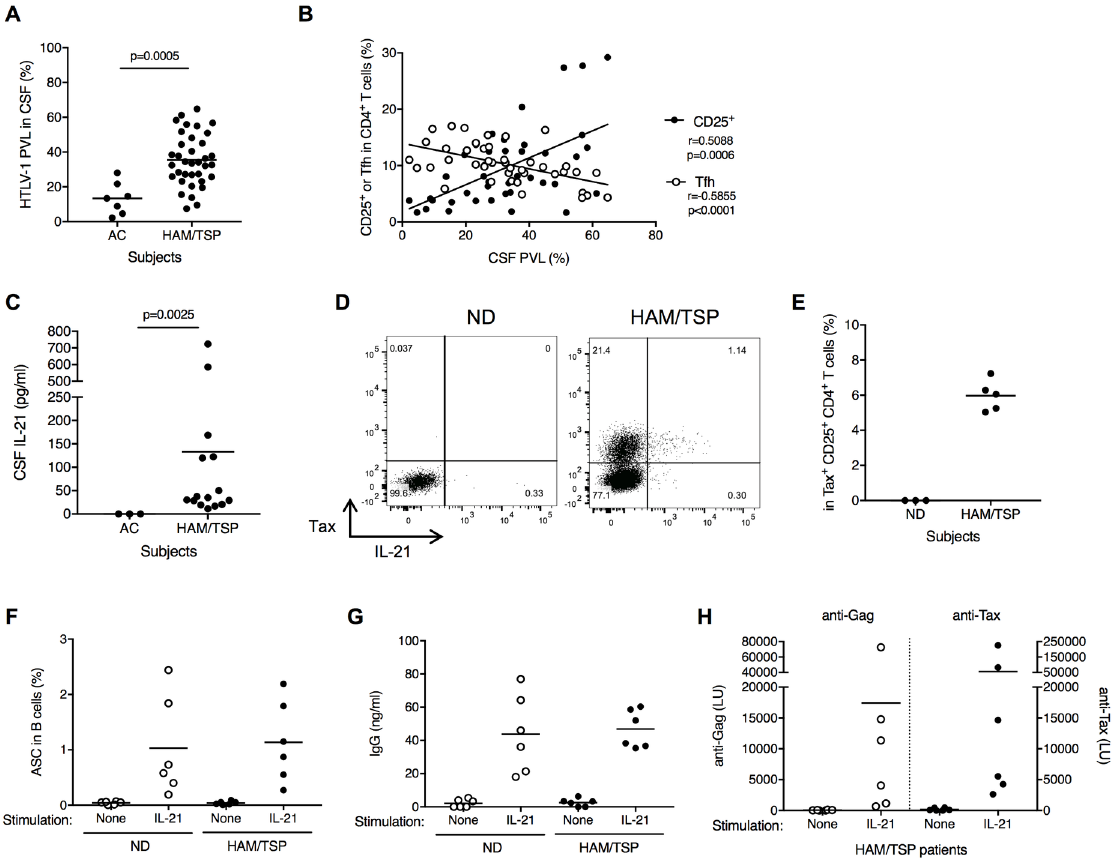
Fig 6. Involvement of CD4 + CD25 + T cells with B cell help in CSF of HAM/TSP patients. (A) Comparison of HTLV-1 PVL in CSF of ACs (n = 7) and HAM/TSP patients (n = 36) using Mann-Whitney Test. (B) Correlation of HTLV-1 PVL with CD4 + CD25 + T cells and memory Tfh cells in HTLV-1-infected subjects using Spearman’s rank correlation test. (C) Comparison of IL-21 in CSF of HAM/TSP patients and ACs using unpaired t test. (D) Representative dot plots of IL-21 and Tax staining in CD4 + CD25 + T cells of a ND and a HAM/TSP patient after culture for 24 hours without any exogenous stimulation. (E) Detection of IL-21 in Tax-expressing CD4 + CD25 + T cells of HAM/TSP patients after culture for 24 hours without any exogenous stimulation. (F) Generation of ASCs subsets in B cells cultured with and without rhIL-21. The data were obtained from cultured B cells of NDs and HAM/TSP patients (n = 6). The horizontal line represents the mean. (G) Detection of human IgG in the B cell culture supernatants of NDs and HAM/TSP patients. (H) Detection of antibodies for HTLV-1 Gag and Tax in the B cell culture supernatants of HAM/TSP